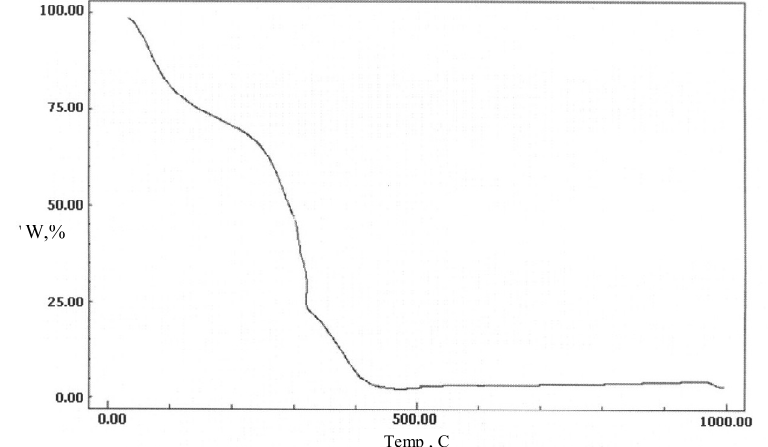
Figure 1. Thermogravimetric analysis of Mn(II)-L 1 L 2 mixed ligand